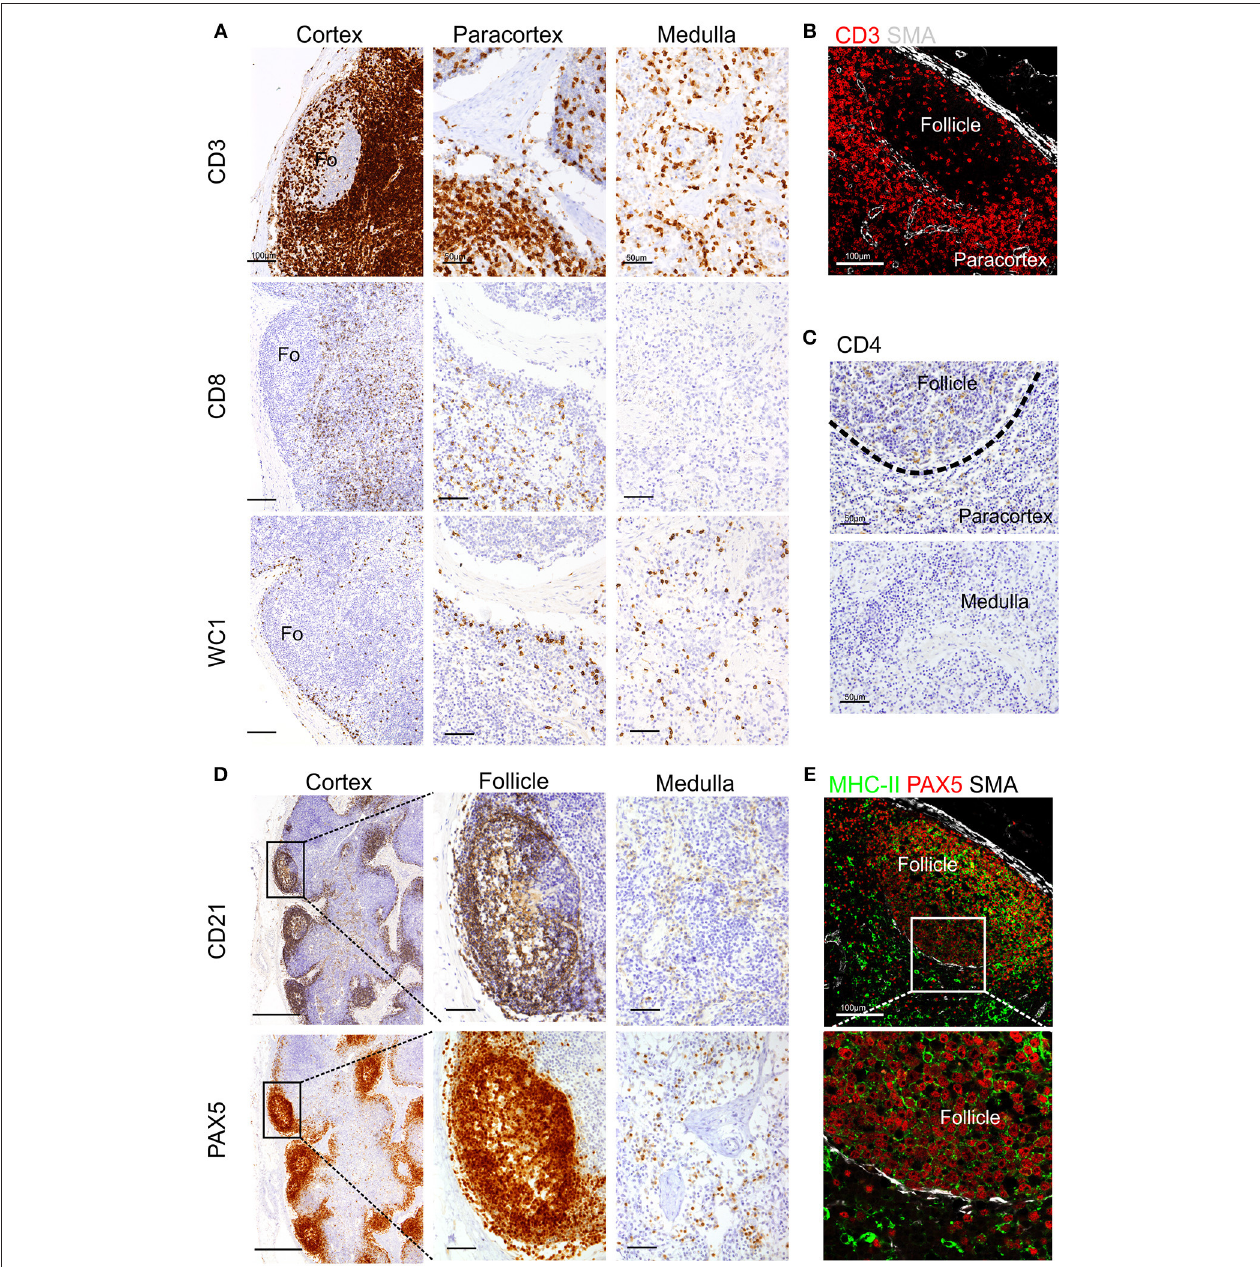
FIGURE 1 | Identification of sheep lymphocytes by immunohistochemistry and immunofluorescence. Representative immunohistochemistry and confocal micrographs of sheep lymph node sections derived from paraffin-embedded tissues fixed in zinc salt solution. (A) Immunohistochemistry: sections were stained for CD3, CD8 (clone 38.6), or WC1 to identify T lymphocytes, cytotoxic T cells, and gamma-delta T cells, respectively. Scale bar: 100 µ m for cortex and 50 µ m for paracortex and medulla. (B) Confocal microscopy of sections stained for CD3 and smooth muscle actin (SMA, white). (C) Immunohistochemistry of sections stained for CD4 to identify T helper cells. Scale bar: 50 µ m. (D) Immunohistochemistry of sequential sections stained for CD21 and PAX-5 (BSAS protein), both markers to identify sheep B lymphocytes. Scale bar: 250 µ m for cortex and 50 µ m for follicle inset. (E) . Confocal microscopy of sections stained for PAX-5 (red) and MHCII (green) expressed by B lymphocytes, a rim of SMA (white) delimits the follicle. Scale bar: 100 µ m.